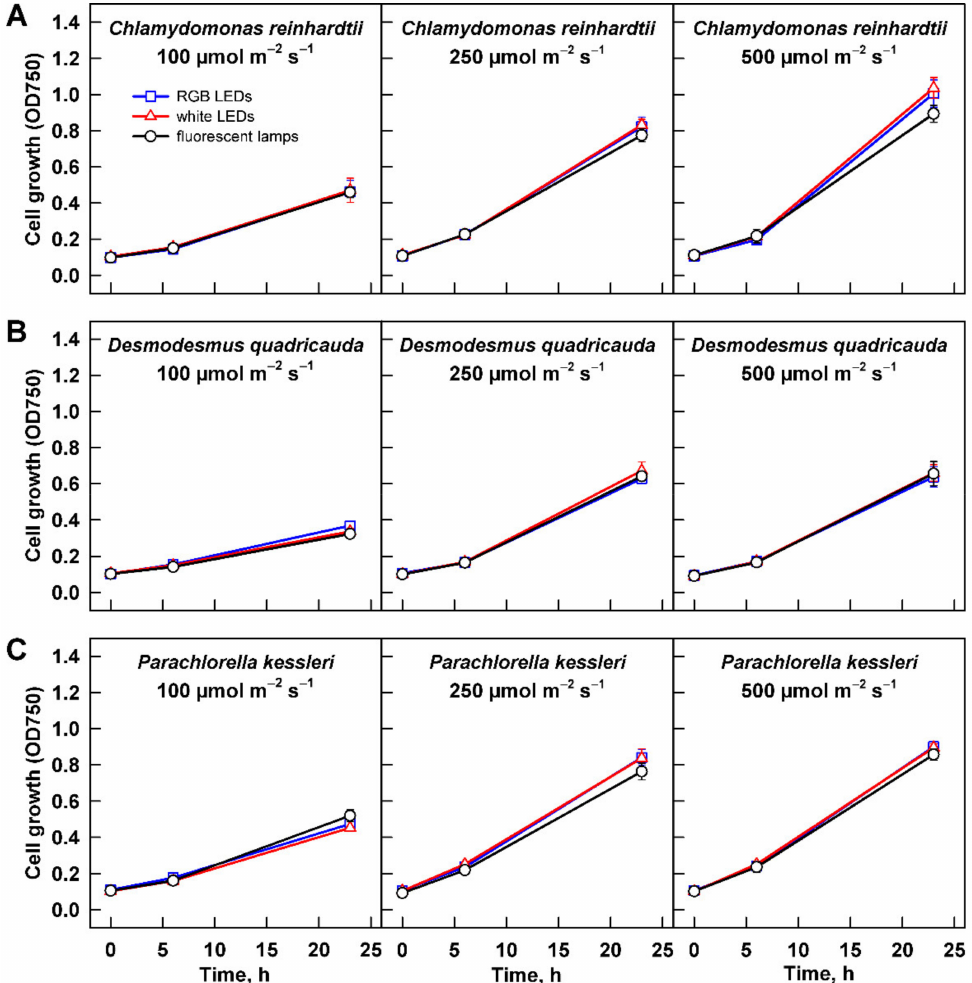
Figure 4. Growth of the cultures cultivated at different light intensities. Cultures of ( A ) Chlamydomonas reinhardtii , ( B ) Desmodesmus quadricauda , and ( C ) Parachlorella kessleri were grown at incident light intensity 100, 250, and 500 µ mol m − 2 s − 1 on different light sources: fluorescent lamps (black circles), RGB LEDs (blue squares), and white LEDs (red triangles). Cell growth is expressed as optical density at 750 nm. Data of three biological replicates are presented as means ±